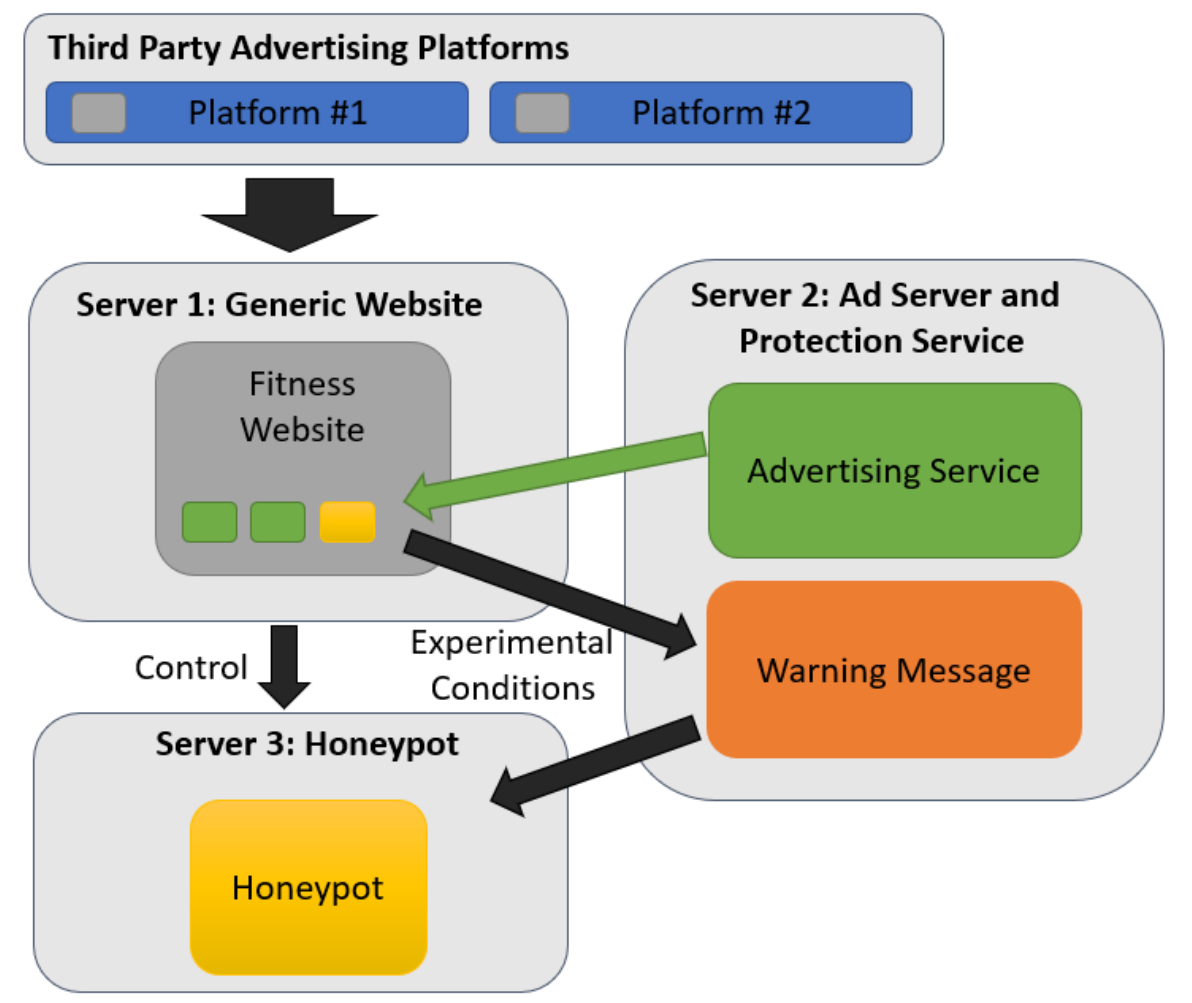
Figure 1. Honey pot server architecture, including third party social media platforms and three servers operated by the research team.